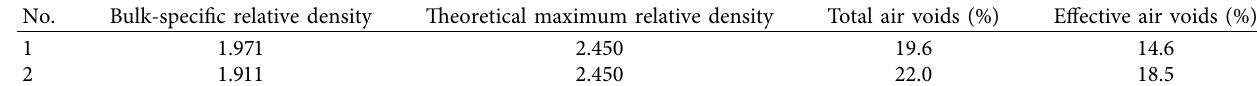
Figure 11: Total air void and effective air void ratios determined using the vacuum sealing method. Table 7: Total air void and effective air void ratios of PFC-13 specimens.